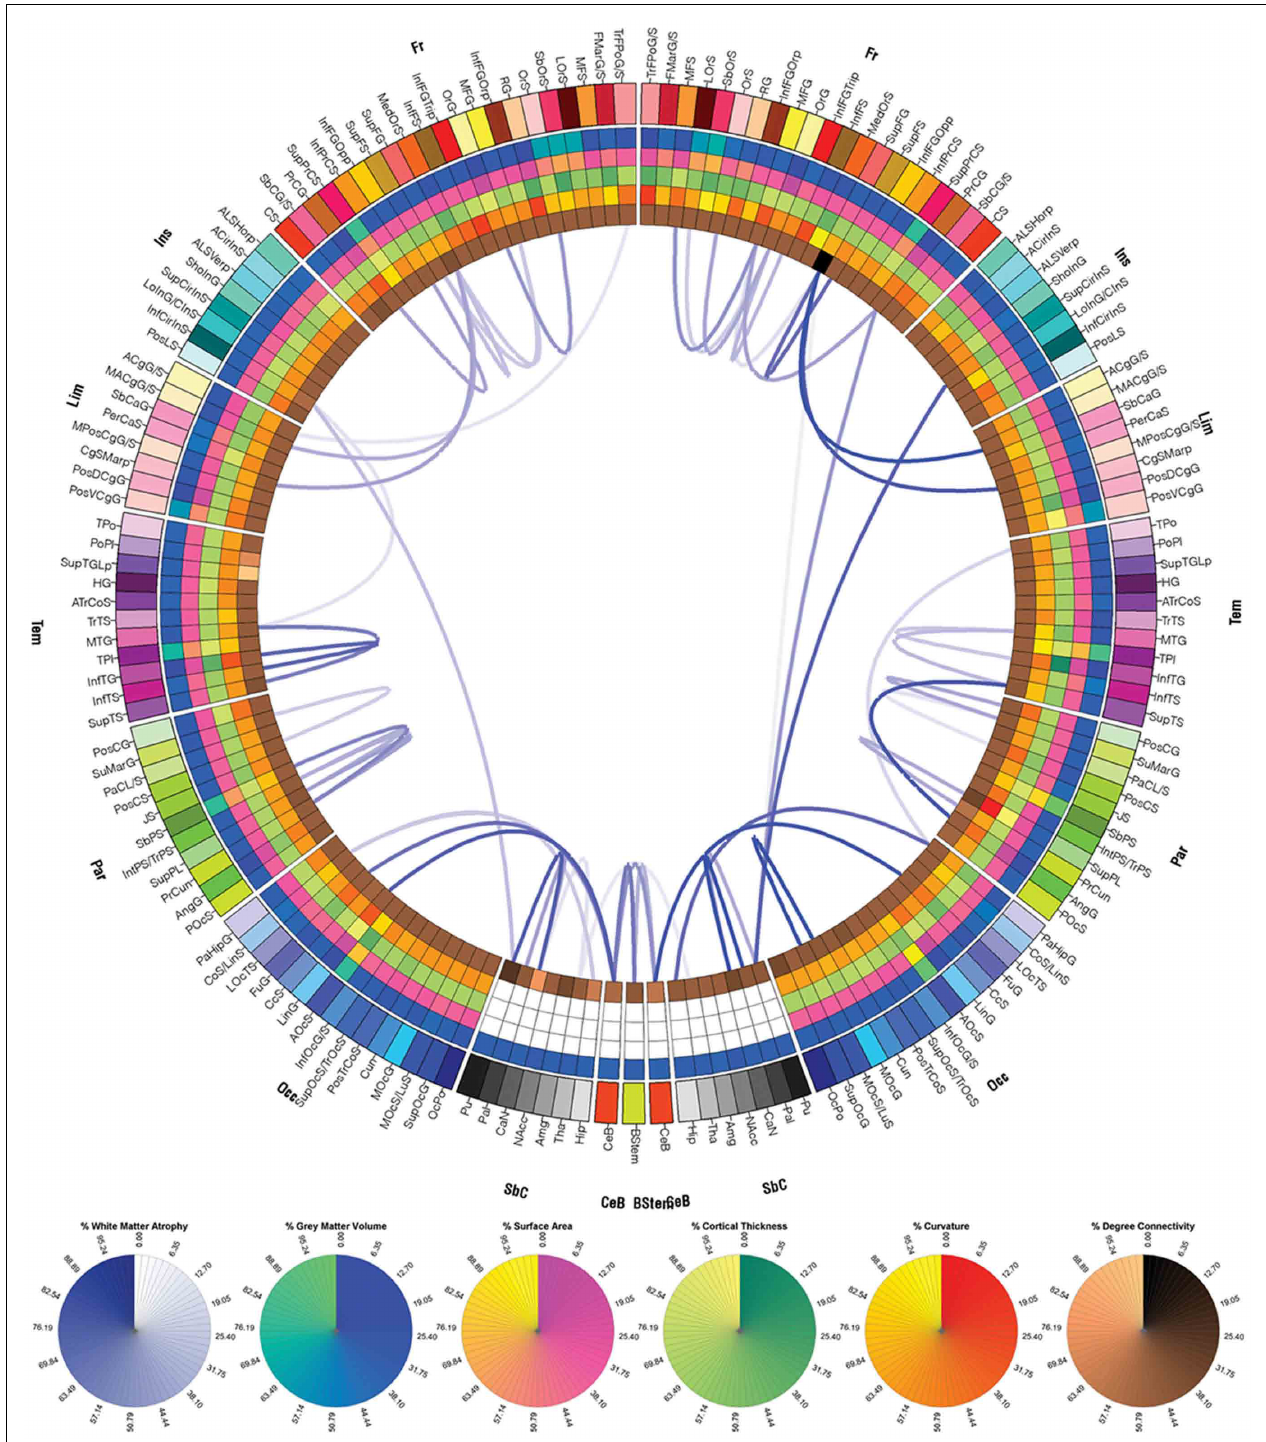
FIGURE 8 |As in Figure 7, for patient 2.